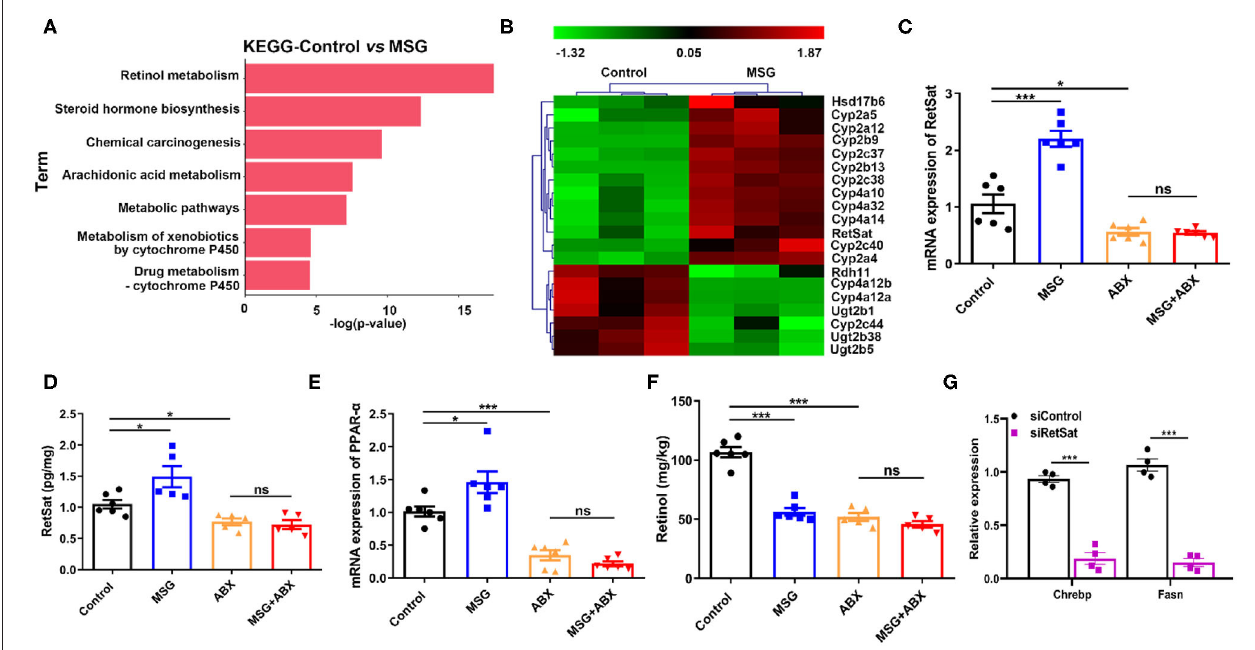
FIGURE 3 | Liver RetSat level is affected by gut microbiota dysbiosis. (A) The functional enrichment of DEGs in the control and MSG group ( n = 3). (B) Heatmap representing the genes significant different in the control and MSG group ( p < 0.05). (C) mRNA expression tested by qRT-PCR (D) and protein content tested by ELISA of liver RetSat. (E) mRNA expression of PPAR- α in the liver. (F) Retinol content in the liver. (G) mRNA expression of Chrebp and Fasn in siControl or siRetSat-treated hepatocytes by qRT-PCR. Data are presented as mean ± SEM, n = 4–6. Data were analyzed by two-way ANOVA followed by post-hoc LSD tests. * p < 0.05, *** p < 0.001, ns, no